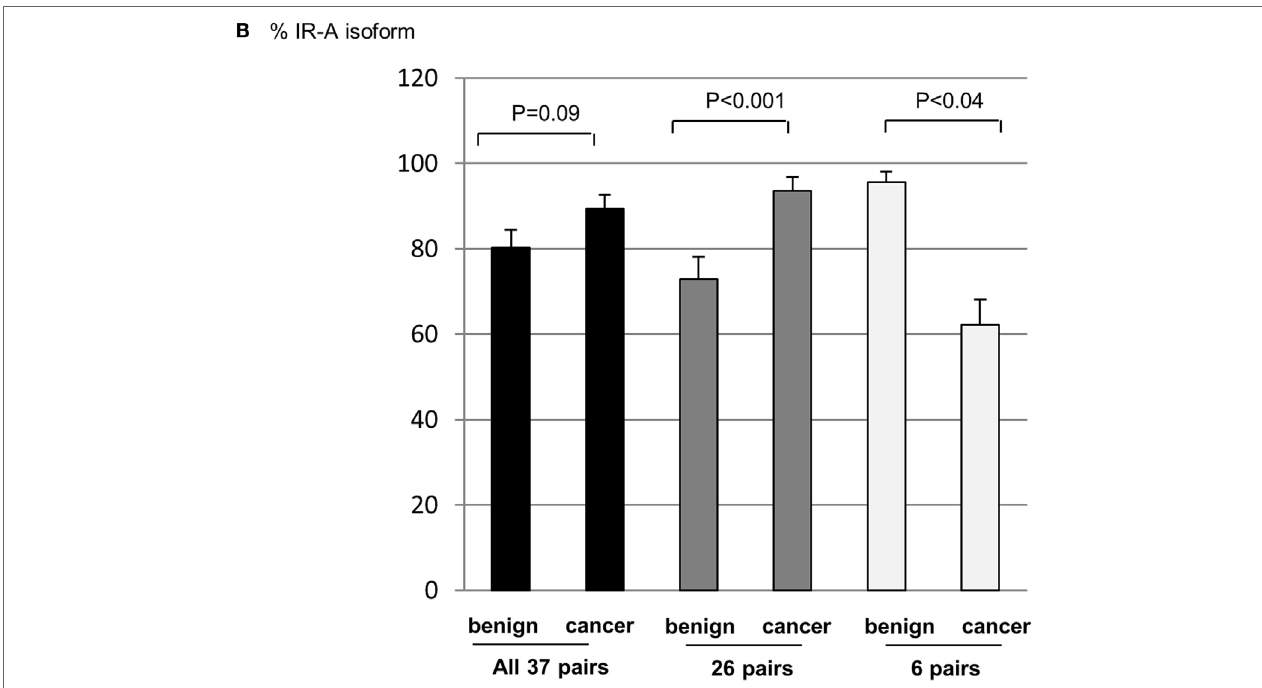
FigUre 5 | (a) FFPE patient samples were collected from patients diagnosed with adenocarcinoma of the prostate. RT-PCR was used to assess the levels of the IR-A and -B isoforms. (B) Graph showing the percentage change in the IR-A isoform relative to IR-B. Error bars represent the SE of the mean, where p < 0.05 represents statistical significance. B, benign; C,